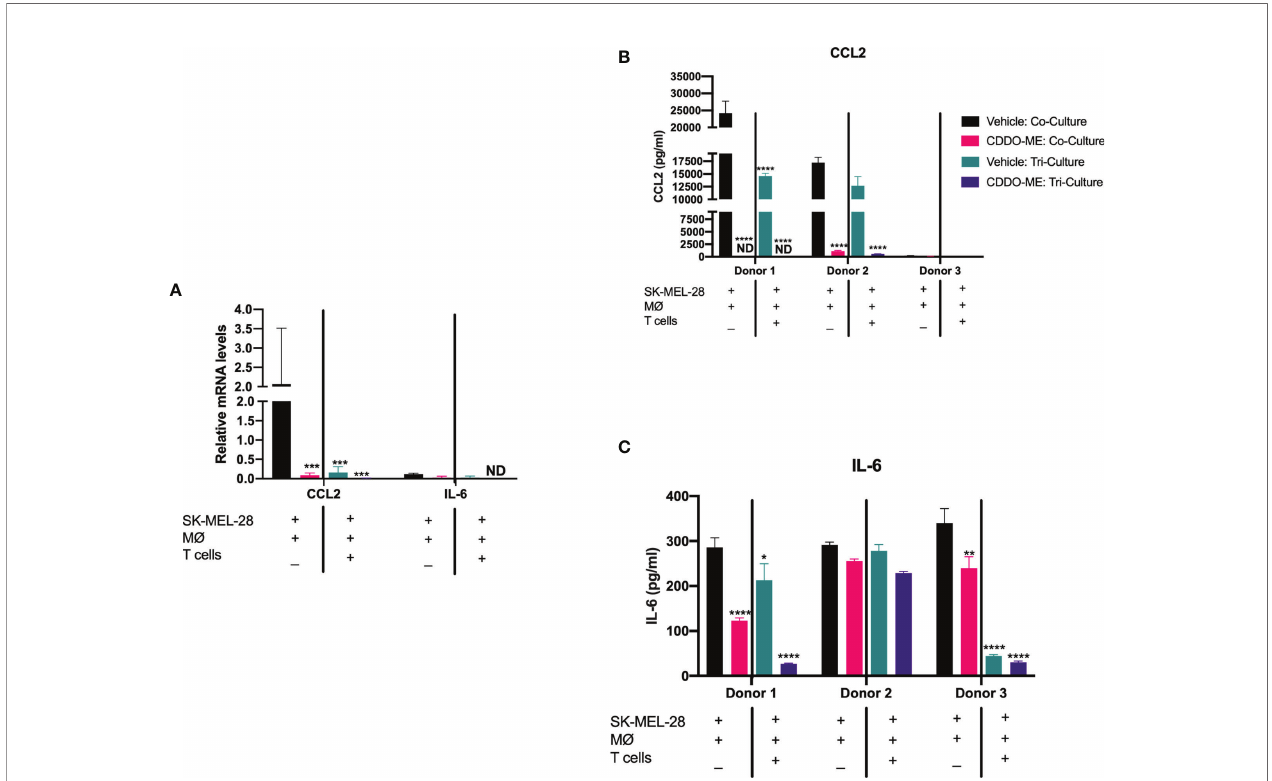
FIGURE 2 | Addition of autologousactivated T cells augments CDDO-Me effects onhuman melanoma-conditioned macrophagecytokine production.Human monocytes were incubated with 20 ng/ml M-CSF,autologousT cellsand SK-MEL-28 melanoma cellsfor 5 days. Cultures were then pre-treated with 300 nM CDDO-Me or DMSO (vehicle control)for 16 h, followedby LPS stimulation (10 ng/ml) for an additional24 hrs. Macrophages were immunophenotyped using fl ow cytometryto verify differentiation ( Supplemental Figure 1 ). (A) TotalRNA was extracted fromLPS-activatedco- or tri-cultures with or without CDDO-Me pretreatment. mRNA transcripts were measured by Taqman qRT-PCR. (B) ELISA analysis of CCL2 and (C) IL-6 collected from co- or tri-culture supernatants. *p< 0.05, **p < 0.01, ***p < 0.001, ****p < 0.0001 vs. untreated control (two-way ANOVA). Not detected (ND). Data shown are representative of results obtainedfromanalysis of 3 individual donors. CDDO-Me effects on mRNA were analyzed by3 separate experiments for each donor; 2 technical replicates were analyzed ineach individual experiment. Error barsrepresent standard deviation